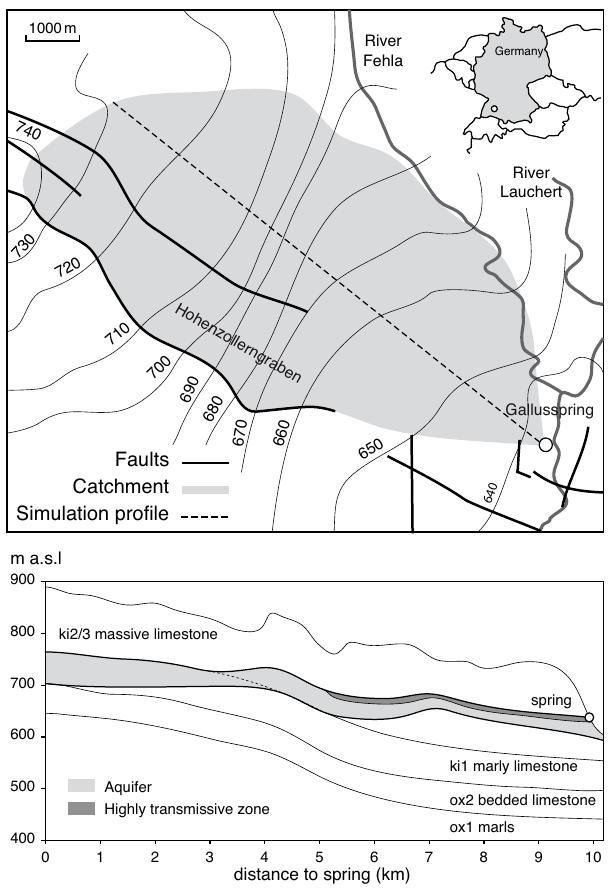
Fig. 2. Gallusquelle catchment and crosssection used for the simu-